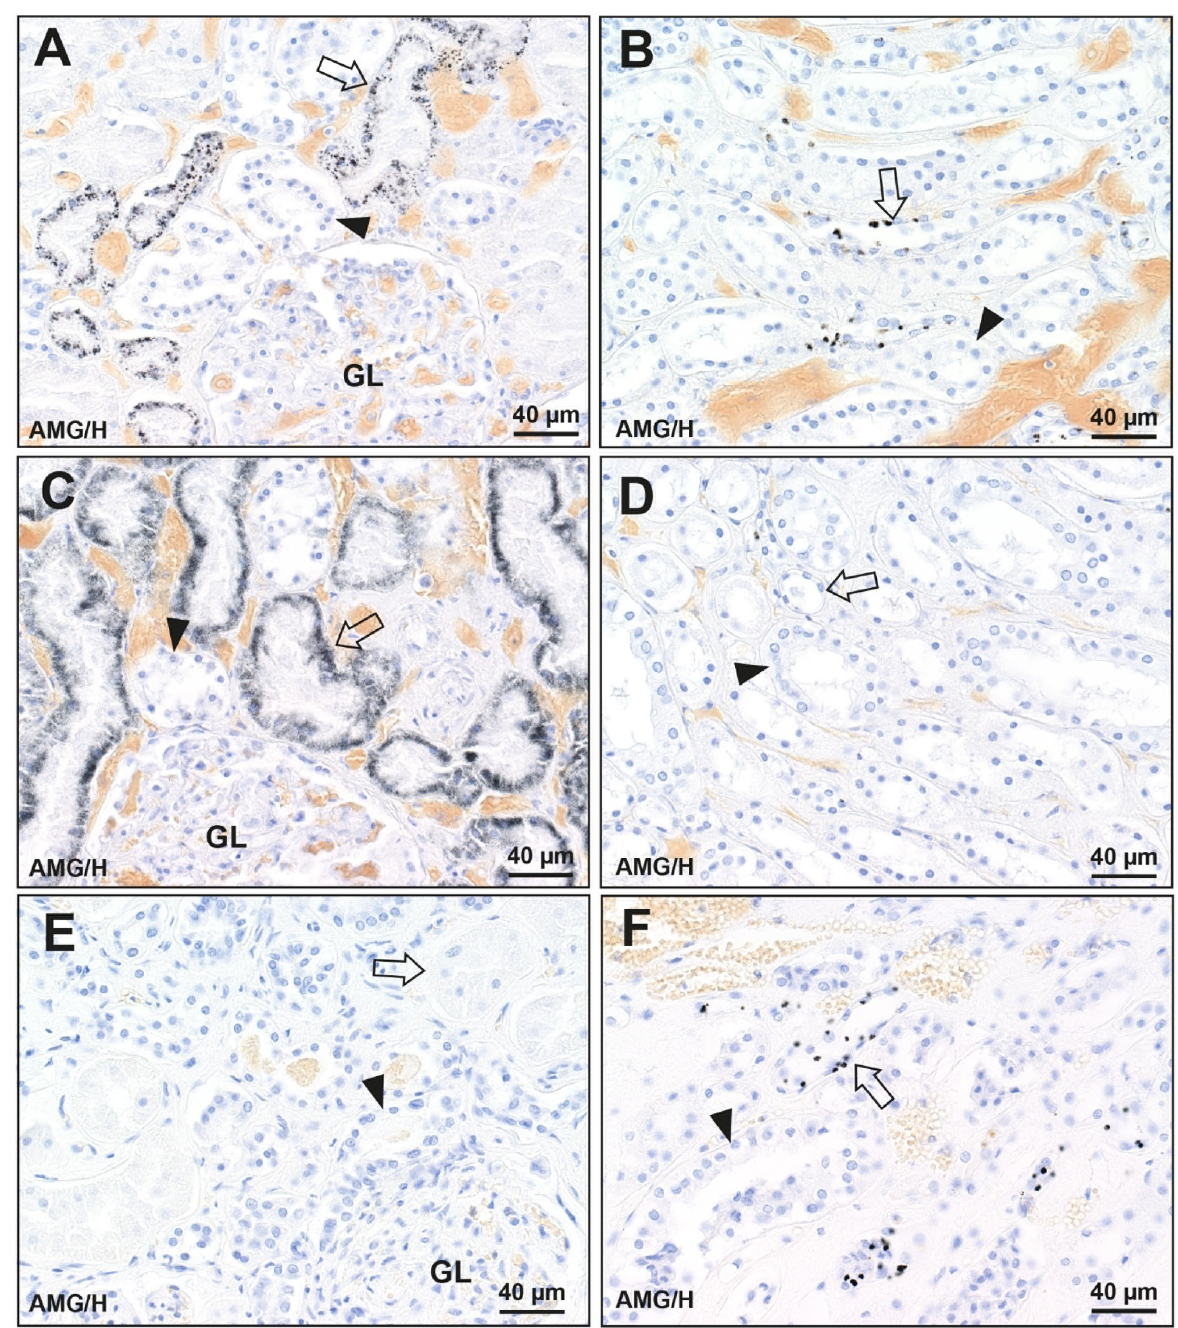
Figure 3. Patterns of mercury distribution in three kidneys (no known mercury exposure). ( A , B ) Mercury in the cortex and medulla (K19). ( A ) In the cortex, black-staining mercury is seen in cells of proximal tubules (arrow) but not distal tubules (arrowhead) or glomeruli (GL). ( B ) In the medulla, discrete mercury granules are seen in cells of Henle thin loops (arrow) but not in collecting ducts (arrowhead). ( C , D ) Mercury in the cortex only (K79). ( C ) In the cortex, mercury is seen in cells of proximal tubules (arrow) but not distal tubules (arrowhead) or glomeruli (GL). ( D ) In the medulla, no mercury is seen in cells of Henle thin loops (arrow) or collecting ducts (arrowhead). ( E , F ) Mercury in the medulla only (K101). ( E ) In the cortex, no mercury is seen in cells of proximal tubules (arrow), distal tubules (arrowhead), or glomeruli (GL). ( F ) In the medulla, mercury is seen in cells of Henle thin loops (arrow) but not in collecting ducts (arrowhead). AMG/H autometallography/hematoxylin, K identify number (see Table